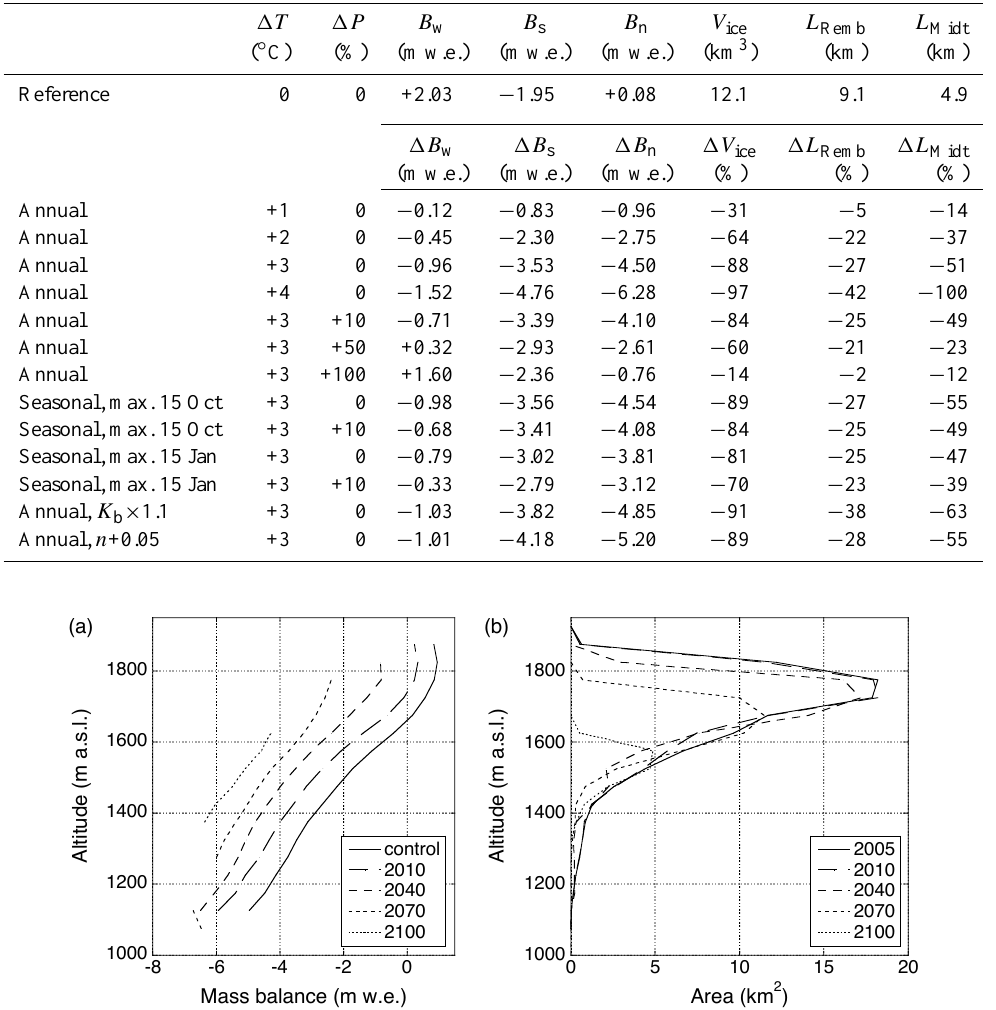
Table 5. Effect of different changes in air temperature ( 1T ) and precipitation ( 1P ) on the modelled winter ( B w ), summer ( B s ) and net ( B n ) surface mass balance and ice volume ( V ice ) of Hardangerjøkulen and the length of Rembesdalsskåka ( L Remb ) and Midtdalsbreen ( L Midt ) in the year 2086. The climate projections are prescribed as an annual and as a seasonally varying change, with the maximum on either 15 October or 15 January. Results from climate projections with a higher wind speed ( K b × 1.1) and increased cloudiness ( n +0.05) are also included. All changes ( 1 ) are given with respect to the reference run with the control climate for 1961–1990. The surface mass balance is the total surface mass balance over the modelled ice cap.